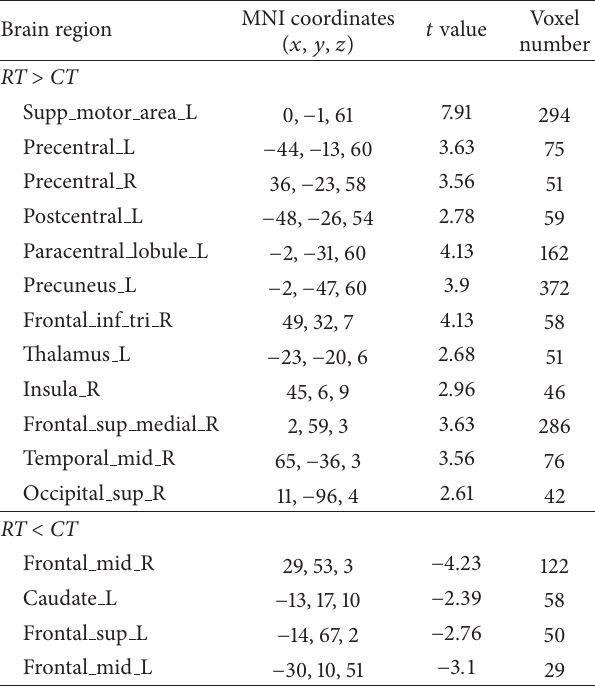
Table 2: Brain regions with significant clusters and peak voxel coordinates showing FA difference between pre- and post-rTMS treatment.